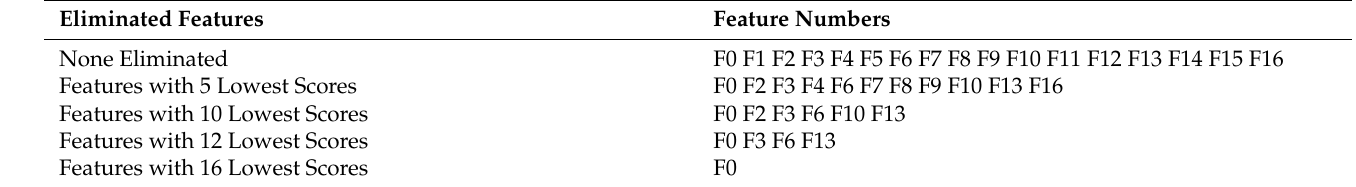
Table 4. The list of feature sets that were used in ML algorithms. It was started with all features and the elimination of less informative features was